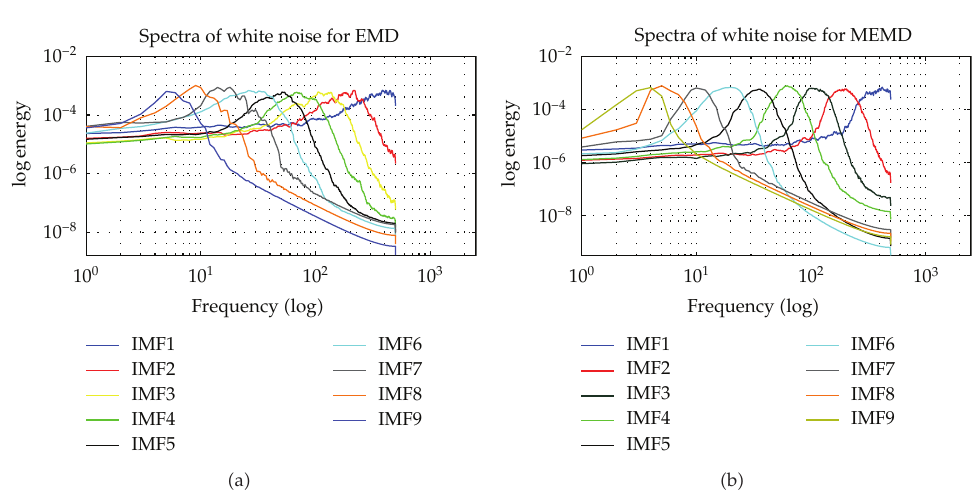
Figure 4: Spectra (cid:2) smoothed (cid:3) of IMFs (cid:2) IMF1–IMF9 (cid:3) of channel 1 obtained for 12 channels white Gaussian noise via the standard EMD (cid:2) a (cid:3) and MEMD (cid:2) b (cid:3) . Overlapping of the frequency bands of the IMFs is reduced with